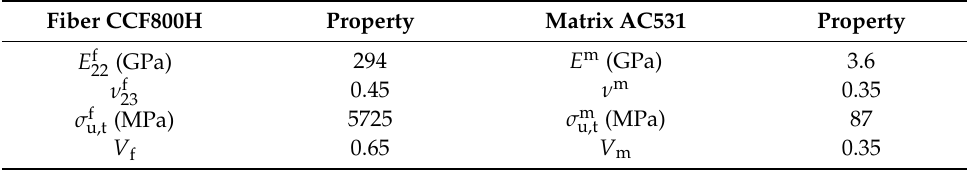
Table 1. Constituent properties of CCF800H/AC531.